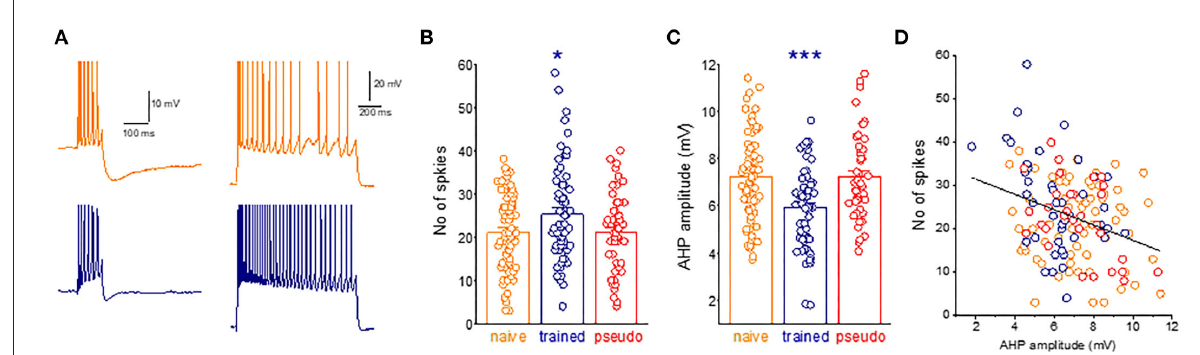
FIGURE2 A widespread learning-induced decrease in the post-burst AHP amplitude mediates enhanced intrinsic neuronal excitability. (A) Examples for current-clamp recordings for AHPs and repetitive spike firing in neurons taken from naive (orange) and trained rat (navy) measurements in a piriform cortex neuron. For AHP recordings, the holding membrane potential is − 60mV, and the AHP is generated by a 100-ms depolarizing current step, with the intensity that generates a train of six action potentials. The presented trace is an average of five consecutive recordings made within intervals of 10s. Repetitive spike firing is shown in the same neurons in response to intracellularly applied 1-s depolarizing, with a stimulus intensity of I th x2. (B) The graph shows the difference between groups in the number of spikes. Dots denote the spikes generated in each neuron. Values represent mean ± SE. * p < 0.05. Between-group comparison was done using one-way ANOVA for the three learning groups, with post-hoc multiple t -tests for each pair of groups. Post-hoc tests show that values of the train group differed significantly from values of the naive ( P < 0.05) and the pseudo-trained group ( P < 0.05). The two control groups did not differ between them ( p = 0.95). (C) The difference between groups in the AHP amplitude. Dots denote the AHP value in each neuron. Values represent mean ± SE. *** p < 0.001. Between-group comparison was carried out using one-way ANOVA for the three learning groups, with post-hoc multiple t -tests for each pair of groups. Post-hoc tests show that values of the train group differed significantly from values of the naive ( P < 0.001) and the pseudo-trained group ( P < 0.001). The two control groups did not differ between them ( p = 0.21). (D) The relation between the AHP amplitude and the number of action potentials generated by each neuron. Results are shown for 48 neurons. A highly significant negative correlation between the AHP amplitude and the number of action potentials is apparent ( r = − 0.32, p <